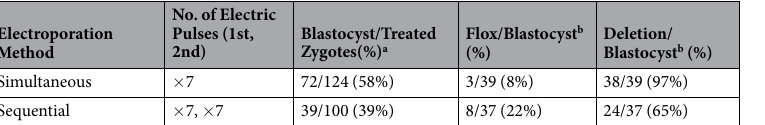
Table 2. Generation of Tet3 Flox Blastocyst Embryos by Electroporation. Samples were analyzed at blastocyst stage. a Embryo survival rates (blastocyst/treated zygote). b Samples that were not amplified by PCR were excluded because they could have contained chromosomal deletions. Detailed data are shown in Table